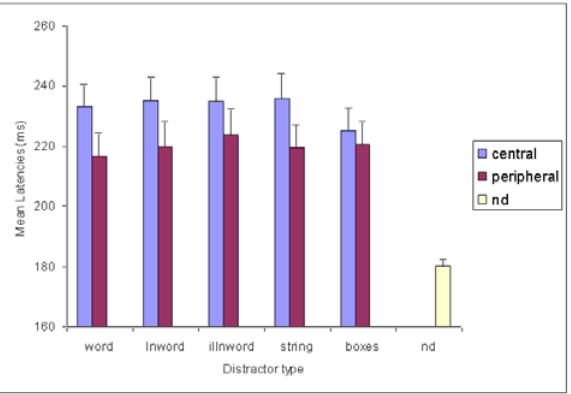
Figure 1: The mean saccade latencies for each of the five distractor types plotted for each of the two distractor eccentricities, with, additionally, the mean for the no distractor condition. Error bars denote 1 standard error from the